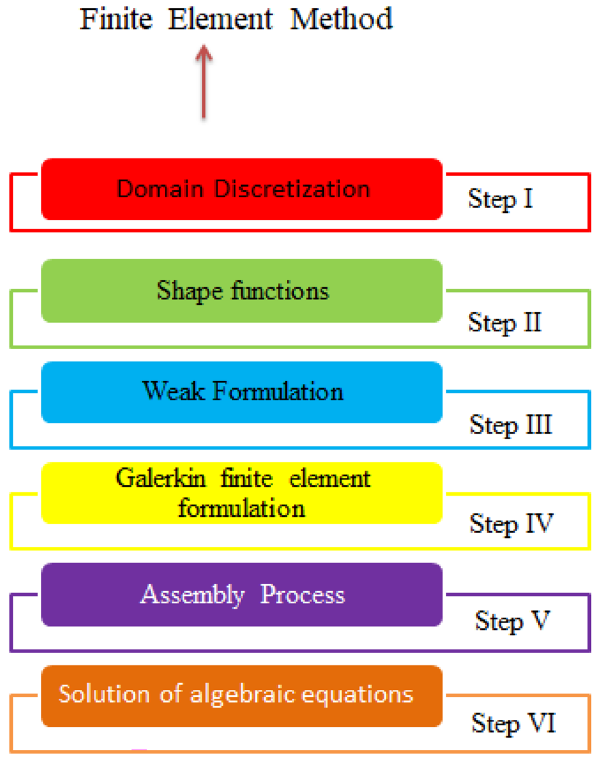
Figure 2. FEM related steps.